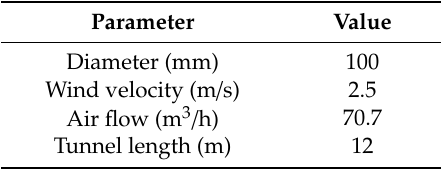
Table 2. Main parameters of the EAHE system.